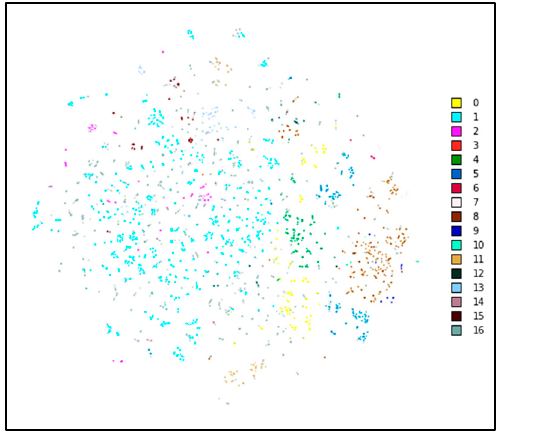
Figure 10. Detection results of the baseline without and with RIC Loss. The blue ellipse represents false alarm. ( a , c ) Detection results of the baseline. ( b , d ) Detection results of the baseline with RIC loss.